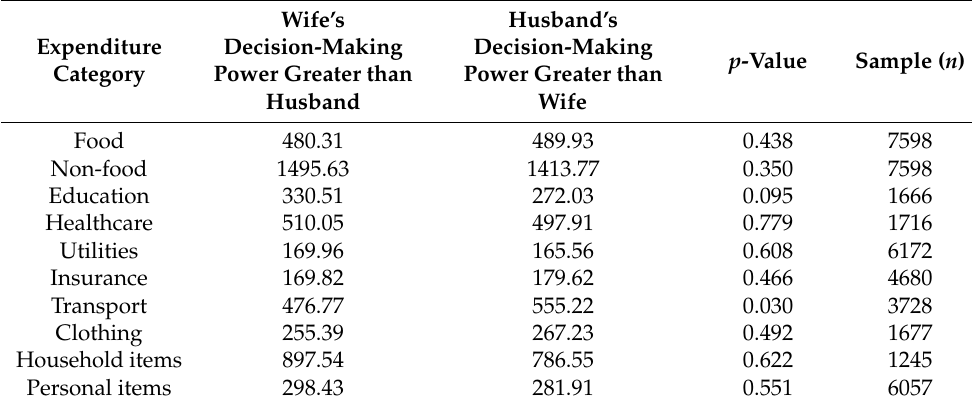
Table 4. Monthly per capita household expenditure by decision-making power.